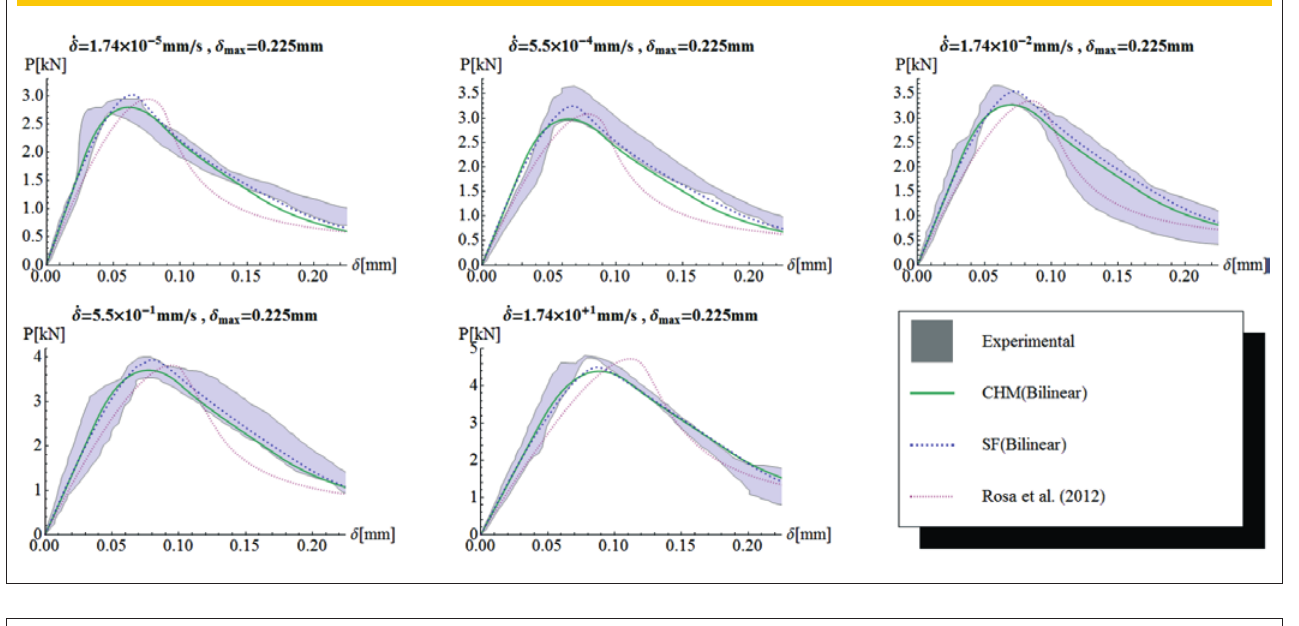
Figure 23 – curves for the range of 0 to 0.225 mm of simultaneously fit P- d of bilinear and viscous model